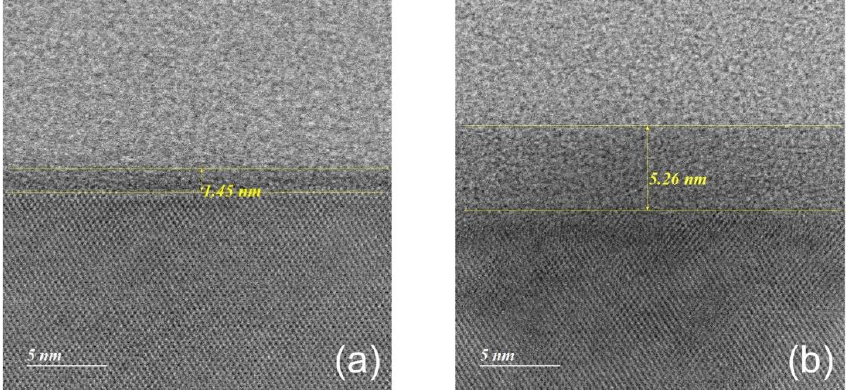
Figure 11. STEM images of the oxide layer on Si measured ( a ) as-received and ( b ) a few days after plasma treatment.